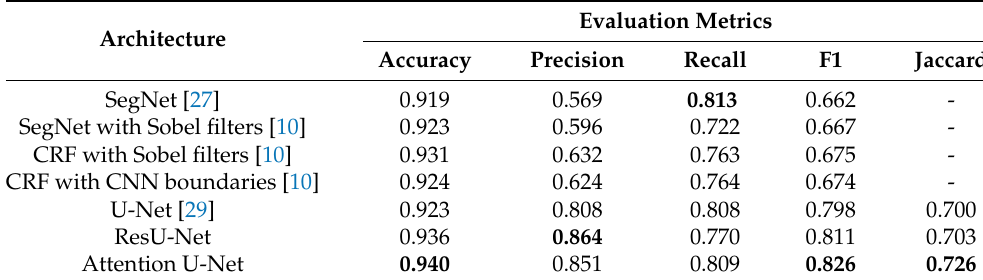
Table 2. Comparison of performance between the proposed U-Net architecture and approaches from the literature on the semantic segmentation task with the SpaceNet 1 dataset. Best scores are annotated in